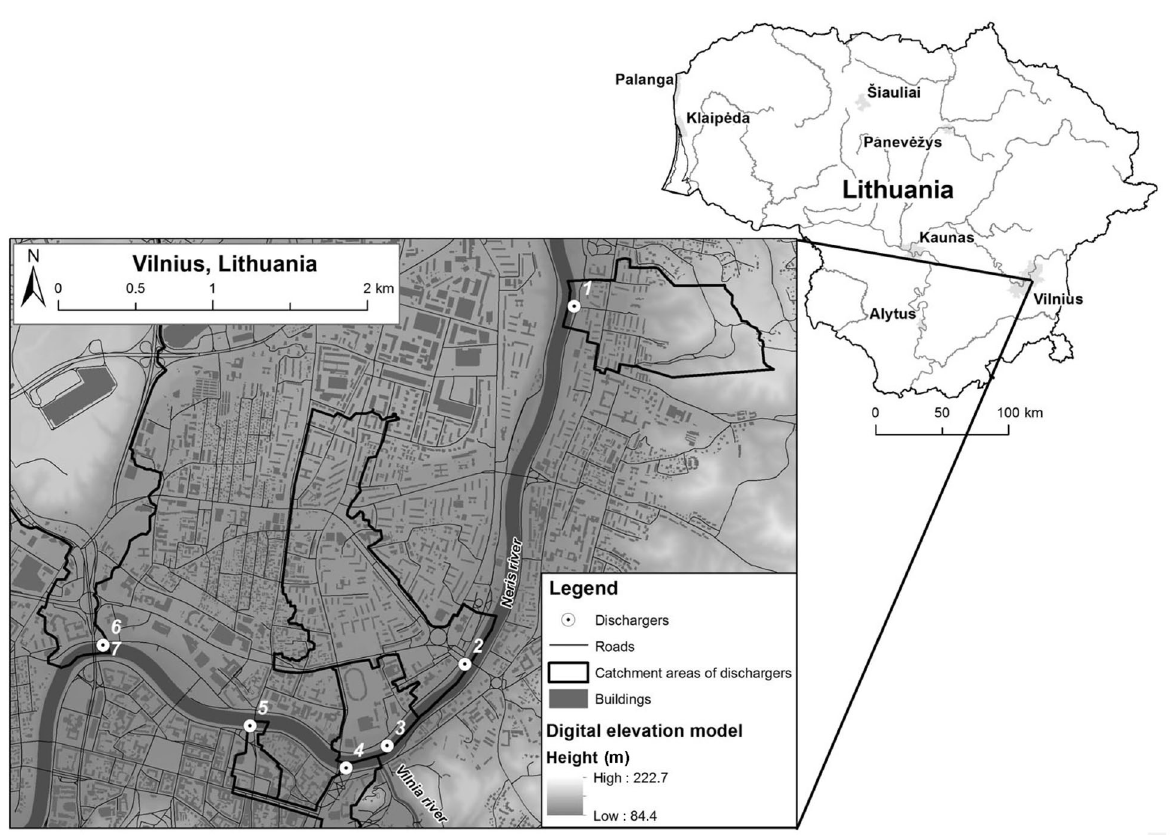
Fig. 1. Survey area and catchment areas for each discharger along the Neris River, Vilnius city